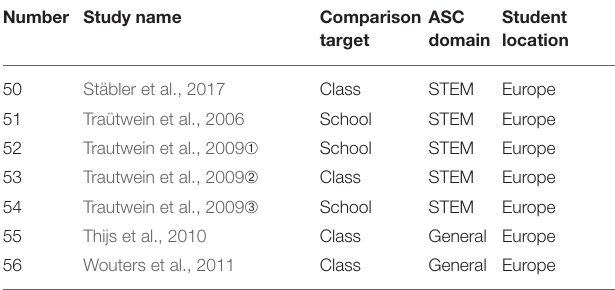
TABLE 2 | Summary of studies included in the meta-analysis